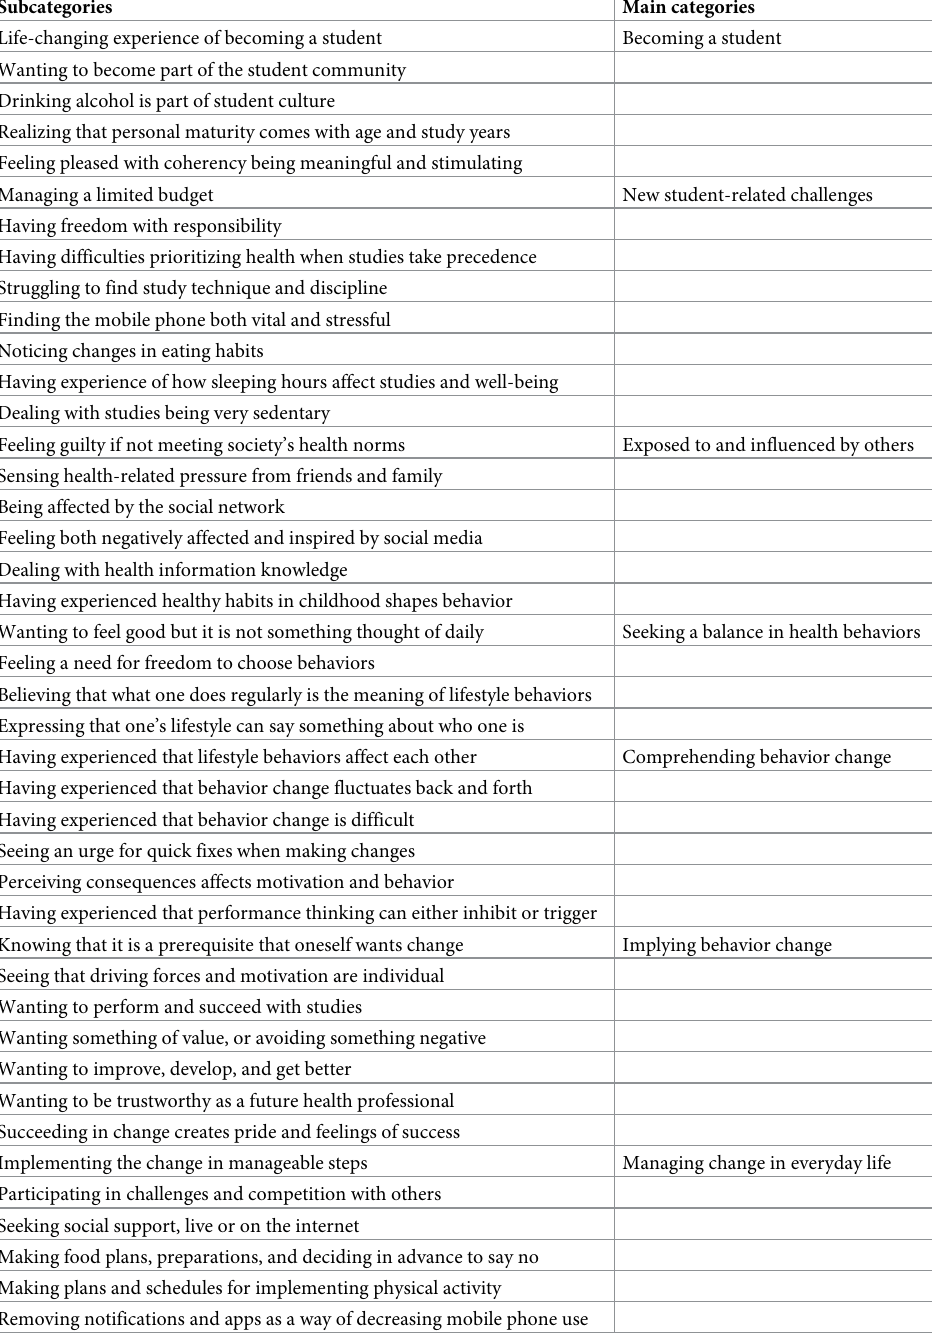
Table 2. Sub- and main-categories from students’ views and experiences of health-related behavior and behavior